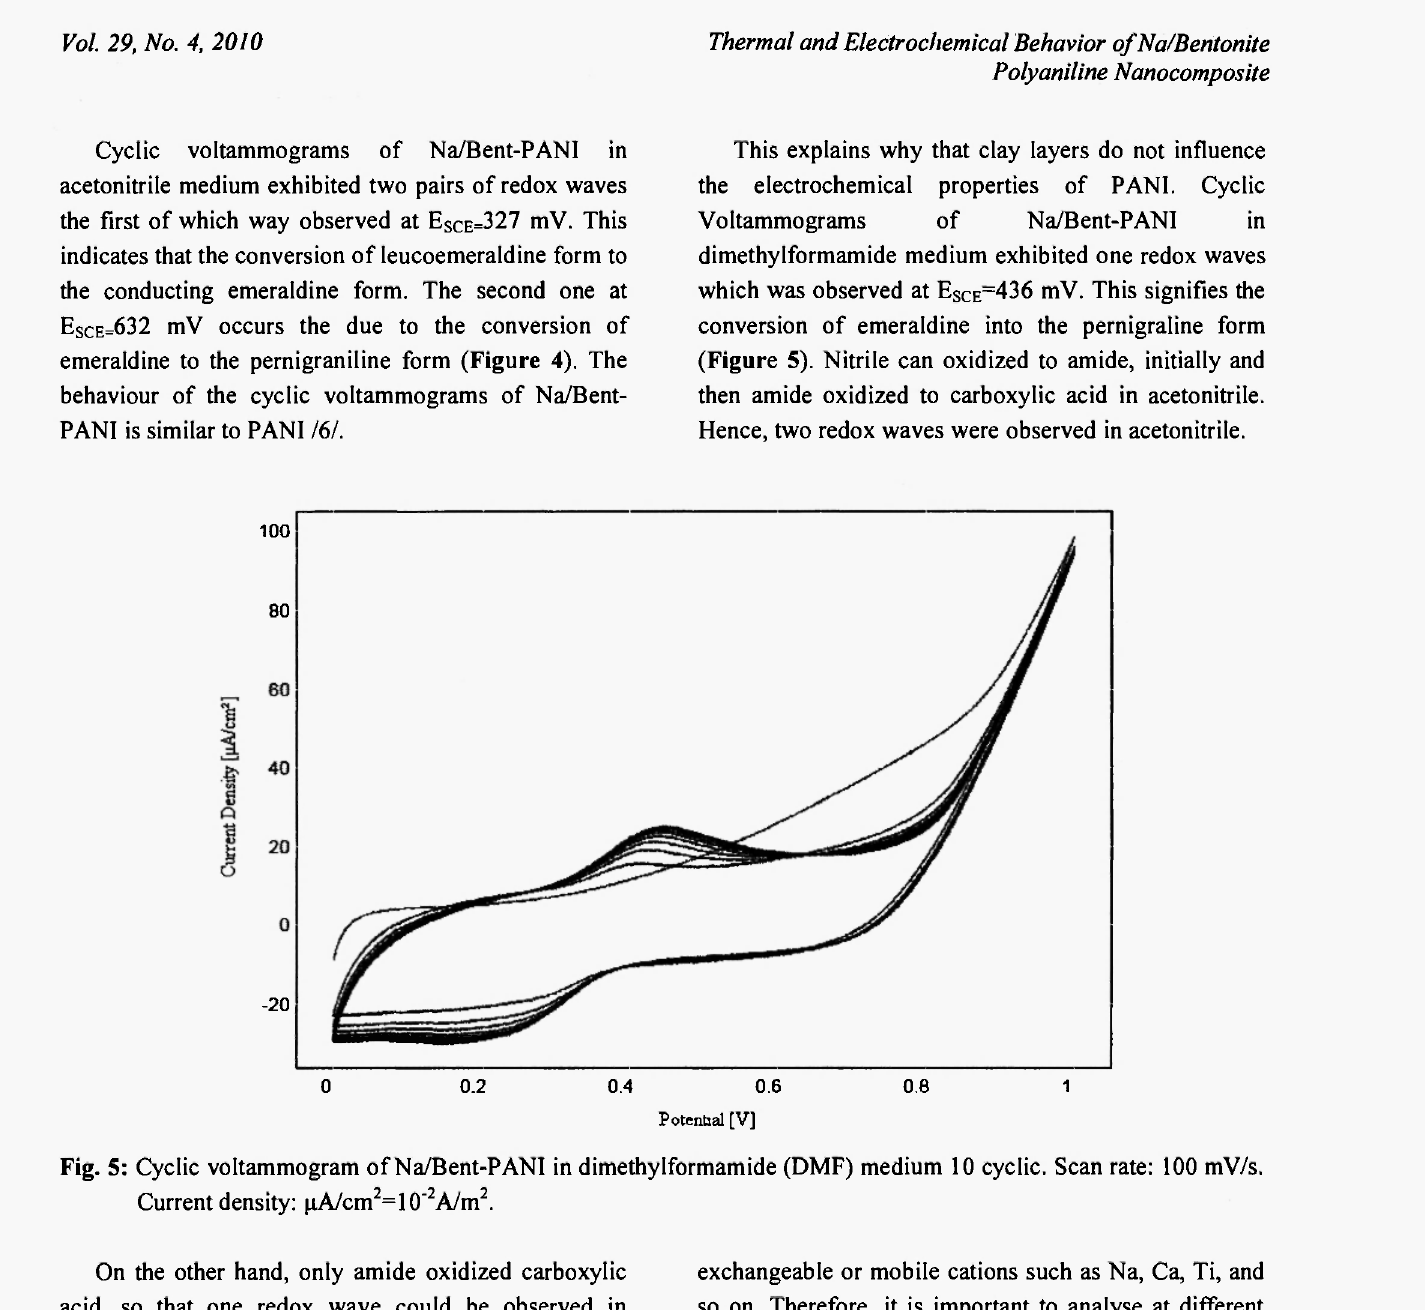
Fig. 5: Cyclic voltammogram of Na/Bent-PANI in dimethylformamide (DMF) medium 10 cyclic. Scan rate: 100 mV/s. Current density: μΑΛ;πι 2 =Τ0" 2 Α/πι 2